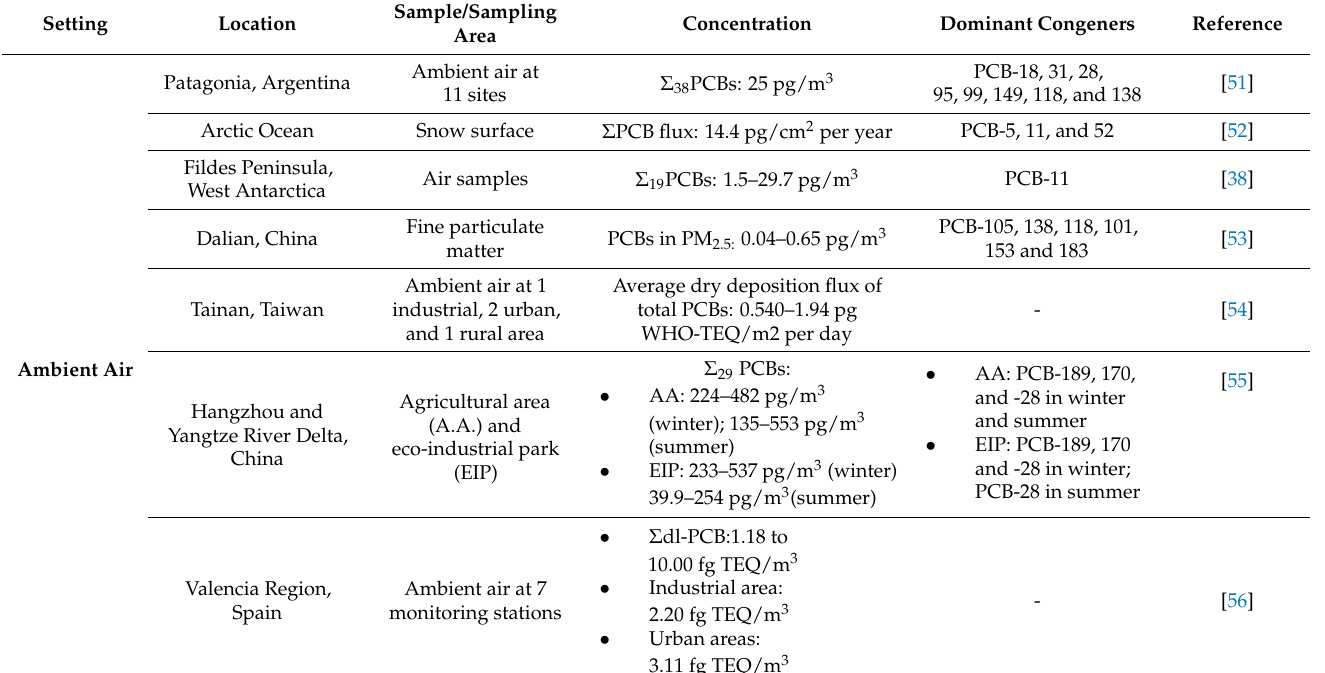
Table 1. Concentration of PCBs in outdoor environments around the